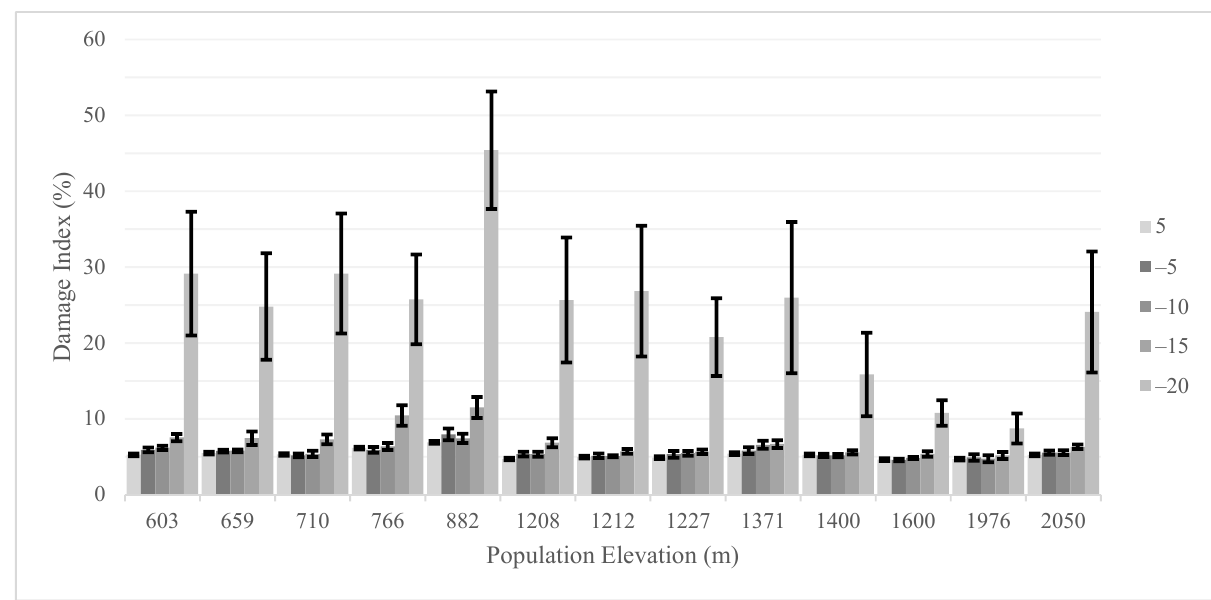
Figure 3. Mean (±SE, standard error) damage index (%) of frost damage for koa population from a range of elevations and test temperatures. Tissue samples were from cold-acclimated seedlings from 13 populations. Test temperatures consisted of a control at 5 °C, and four freezing temperatures: − 5, − 10, − 15, and − 20 °C.